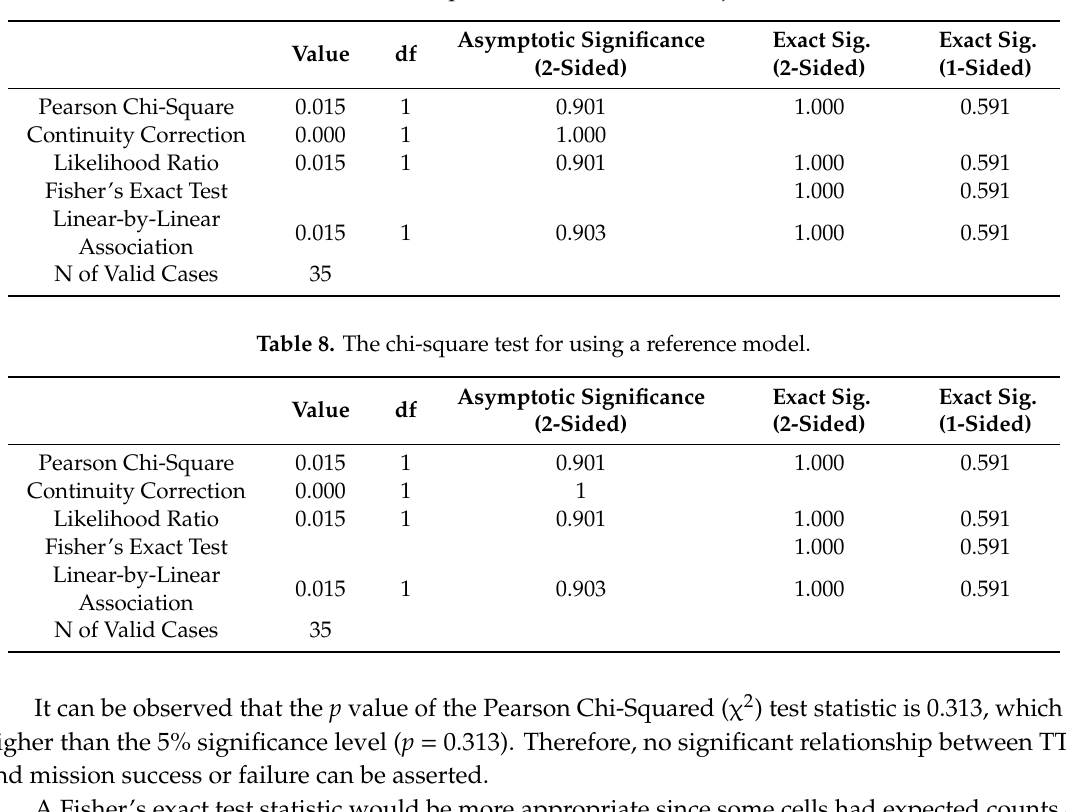
Table 7. The chi-square test for the mission objectives.